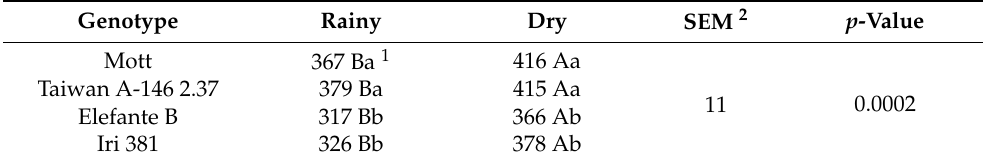
Table 8. Stem in vitro dry matter digestibility (g/kg dry matter) as affected by the interaction between genotype and season for elephantgrass genotypes at Garanhuns, Pernambuco, Brazil.